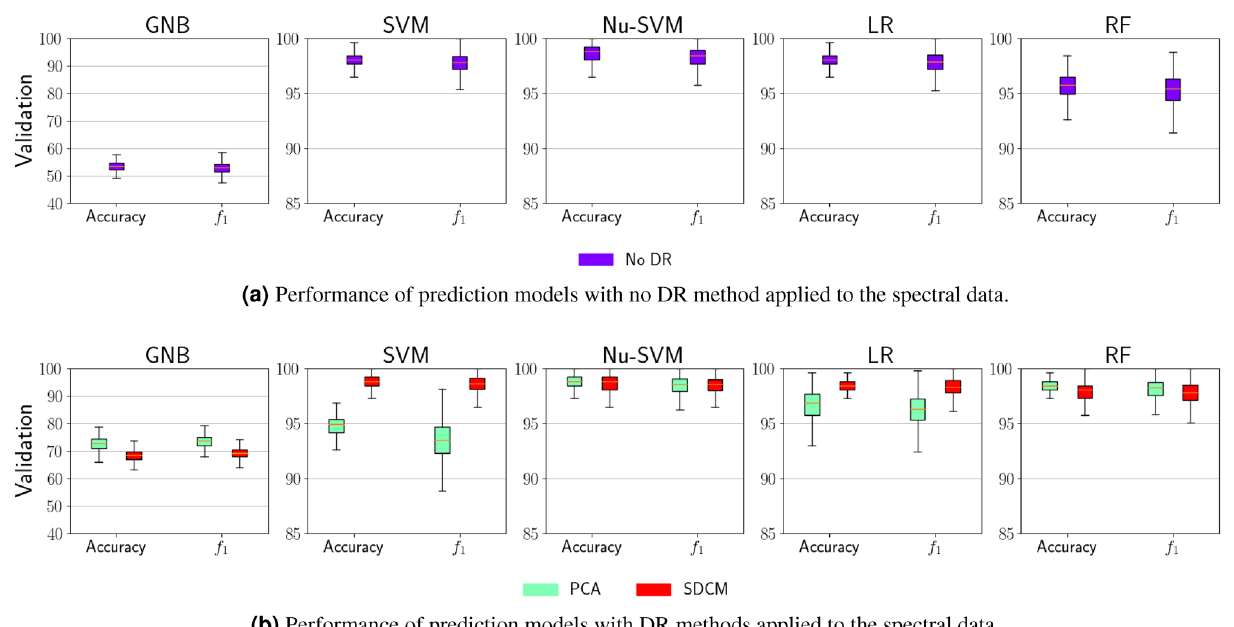
Figure 2. ( a ) Performance of prediction models with no DR method applied to the spectral data. ( b ) Performance of prediction models with DR methods applied to the spectral data. Overview of the prediction performance of ML models for PL-based sample identification. The accuracy and the f 1 score are presented as box plots and are calculated during the validation stage. The colored boxes show the quartiles of the achieved scores, while the whiskers extend to show the rest of the distribution. Each plot presents the prediction performance with a different classifier. All plots in ( a ) show the performance when the spectral data has not been processed with a DR method. All models in the plots in ( b ) are built around spectral data that have been processed with either PCA or SDCM. The prediction performance at all training stages are summarized in Fig.